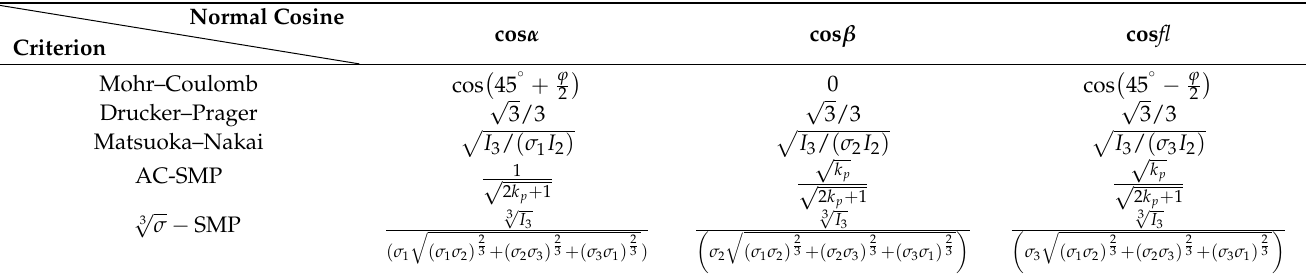
Table 1. The direction cosine of different strength criterion.